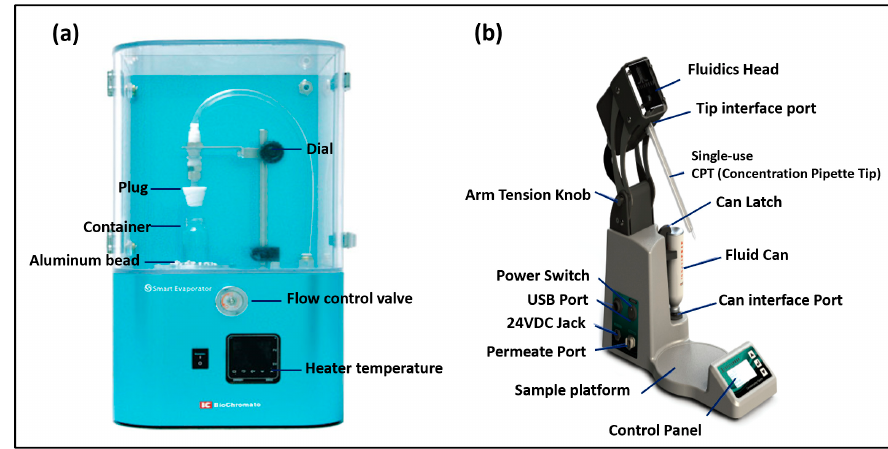
Figure 1. Two concentrating devices: ( a ) a BioChromato Smart Evaporator and ( b ) the Concentrating Pipette (CP ‐ 150). CP ‐ Select has a similar appearance to CP ‐ 150.